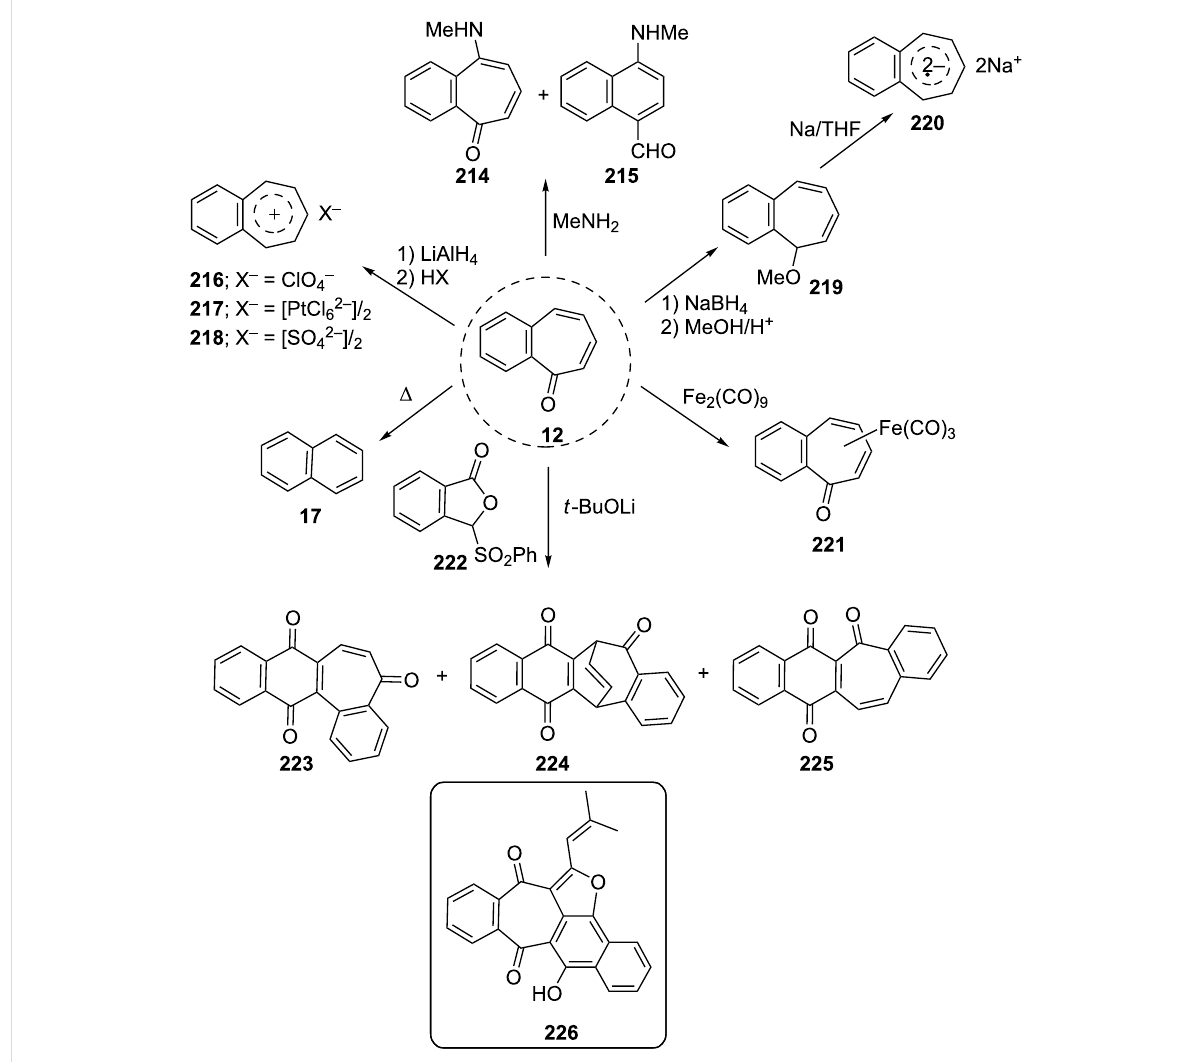
Figure 8: 3,4-Benzotropone ( 13 ) and its resonance structure.